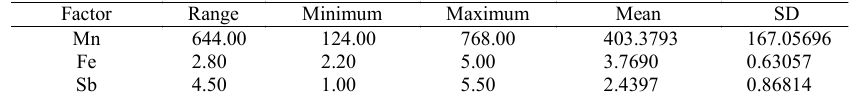
Table 6: Transfer factor (TF) of heavy metals in agriculture crops grown at Hamedan City